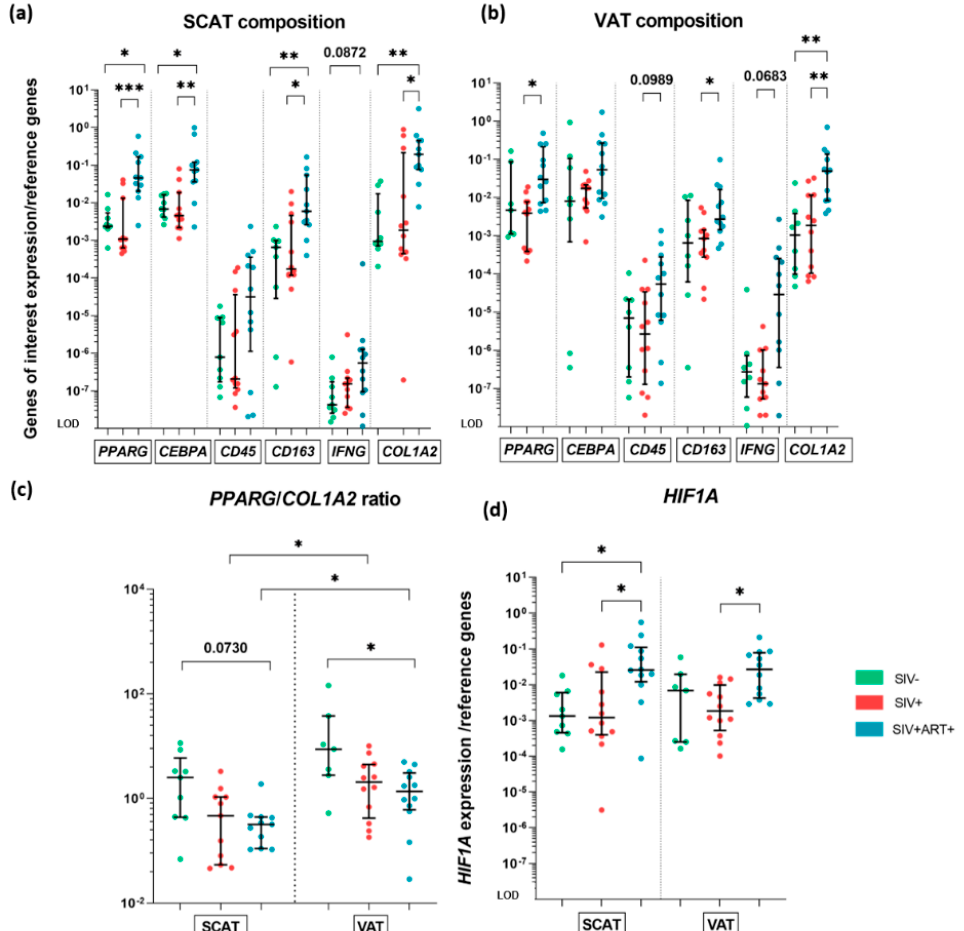
Figure 2. Gene expression analysis of AT components, at the whole-tissue level. RT-qPCR analysis of the mRNA expression of genes specifically transcribed in adipocytes ( PPARG and CEBPA ), hematopoietic cells ( CD45 ), immune cells ( CD163 and IFNG ), and ECM ( COL1A2 ) within SCAT and VAT and in the three groups of animals: SIV − (green), SIV+ (red), and SIV+ART+ (blue). Expression of the genes of interest was compared with that of the 18S and PPIA housekeeping genes. The LOD was set to the difference vs. the mean level of housekeeping gene expression after 20 cycles, i.e., a 10 − 8 -fold difference. ( a , b ) The composition of SCAT ( a ) and VAT ( b ) in the SIV − , SIV+ and SIV+ART+ groups. ( c ) The PPARG/COL1A2 ratio in the SIV − , SIV+ and SIV+ART+ groups in SCAT (left) and VAT (right). ( d ) mRNA expression of HIF1A within SCAT (left) and VAT (right) in the SIV − , SIV+, SIV+ART+ groups. The results are quoted as the median [IQR]. Kruskal–Wallis tests associated with Dunn’s multiple comparison test or Mann–Whitney tests were used for unpaired and paired comparisons, respectively. Only significant results and trends are shown: * p < 0.05, ** p < 0.005, *** p <